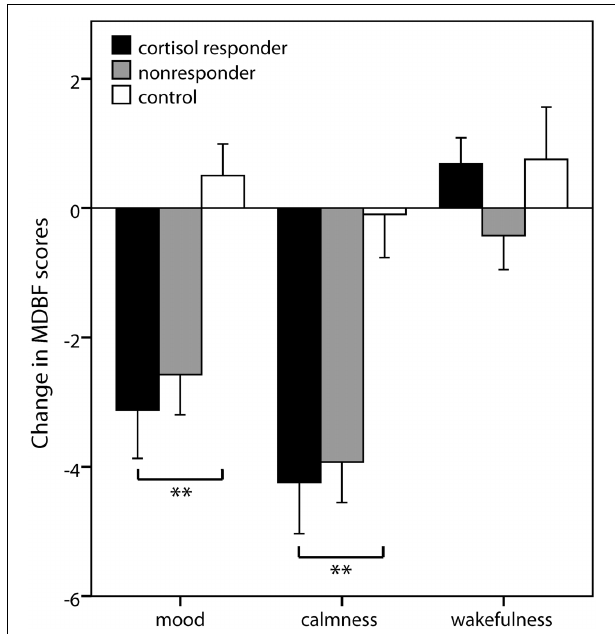
FIGURE 3 | Subjective stress markers. Means ± s.e.m. of the change scores of the mood questionnaire MDBF ( Mehrdimensionaler Befindlichkeitsfragebogen ) from the measurement before the stress induction to the measurement afterwards. Negative change scores indicate an increase in negative mood (mood scale), an increase in restlessness (calmness scale), and an increase in sleepiness (wakefulness scale). Simple contrasts comparing cortisol responders to nonresponders and controls were used to follow up significant main effects ( ∗∗ p < 0 . 01).